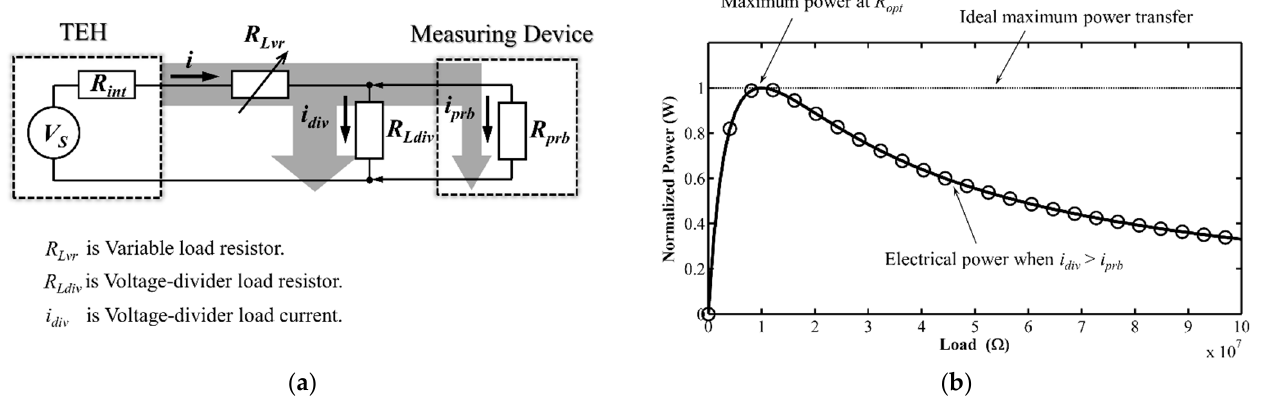
Figure 2. ( a ) Schematic diagram of the developed technique and ( b ) plot of maximum power versus load resistance under the developed technique.